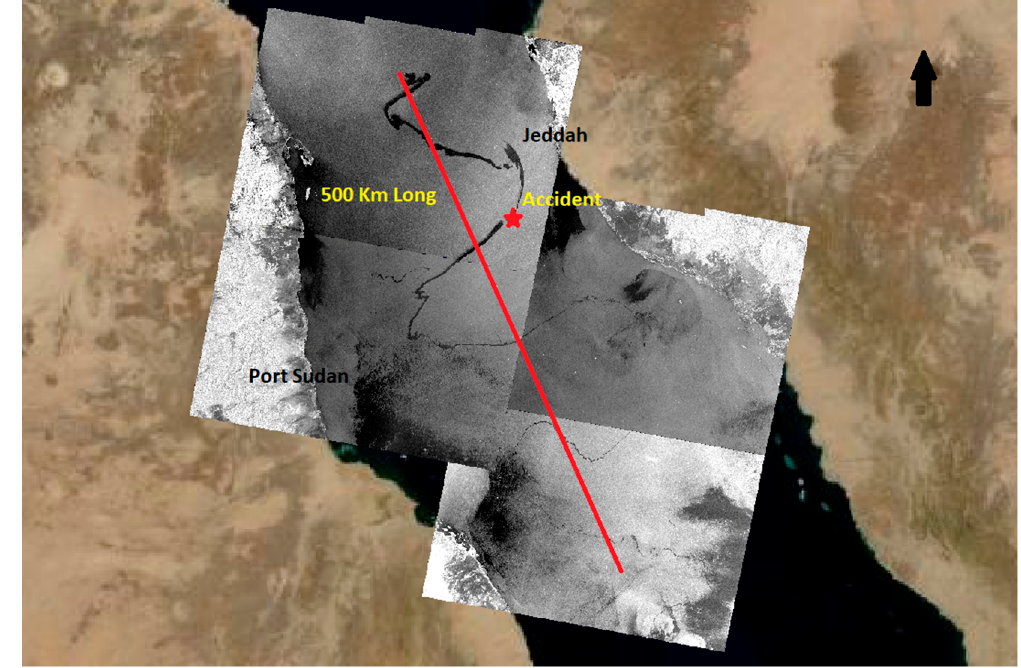
Figure 8. Oil spill extent of the Iranian oil tanker accident near the Saudi Jeddah Port.